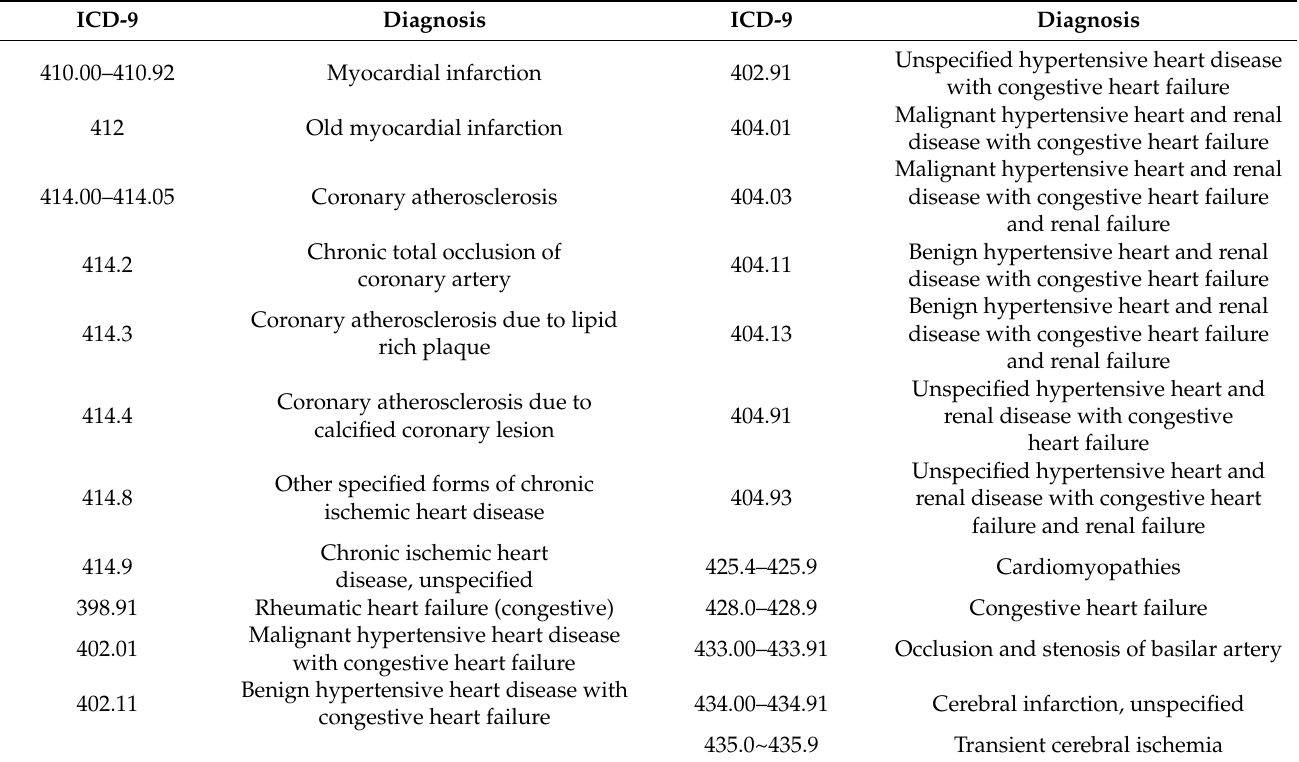
Table 1. ICD-9-CM codes and